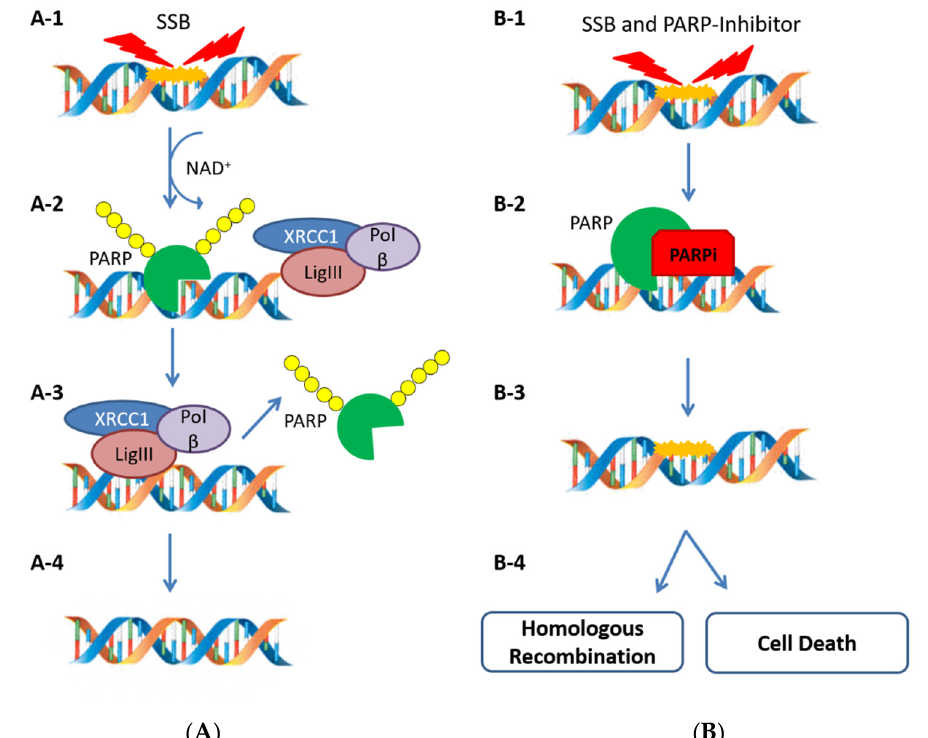
Figure 2. When an SSB occurs ( A-1 ), PARP-1 recruits scaffold proteins and forms an ADP-ribose chain on itself (PARylation) using NAD+ ( A-2 ). The PARylation also promotes PARP-1 dissociation and leads scaffold proteins to repair the SSB ( A-3 and A-4 ). When an SSB occurs in presence of a PARPi ( B-1 ), the PARPi binds the NAD+ binding site in a competitive way ( B-2 ). Since the SSB cannot be repaired by PARP enzyme, the HRR system can repair the damage but the coexistence of HRD prevents the repair and induces cell death ( B-3 and B-4 ).